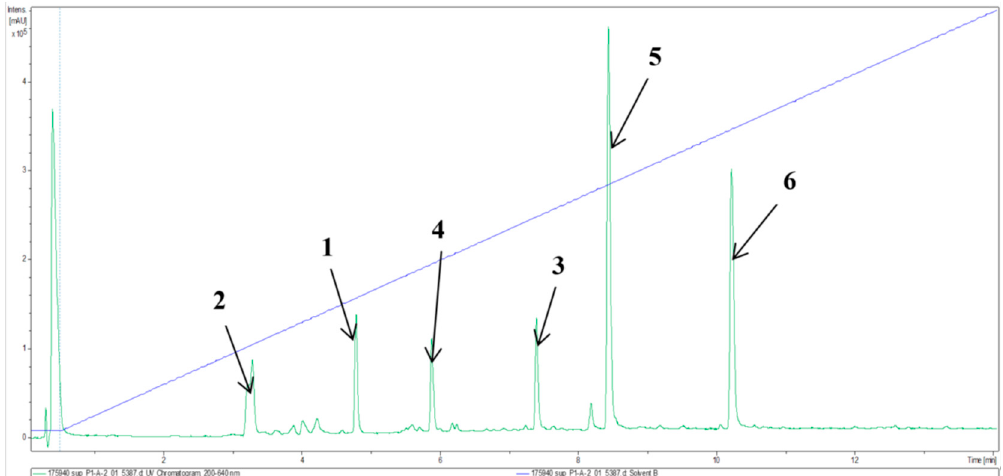
Figure 1. Analytical HPLC–UV/Vis chromatogram of the crude extract from the supernatant of Phoma macrostoma (diode array detection at 200–640 nm). Stationary phase: C18 Acquity UPLC BEH column; for gradient and other details on the experimental setup, see the Experimental section; 1 - 6 : Major metabolites detected (chemical structures see Figure 2).